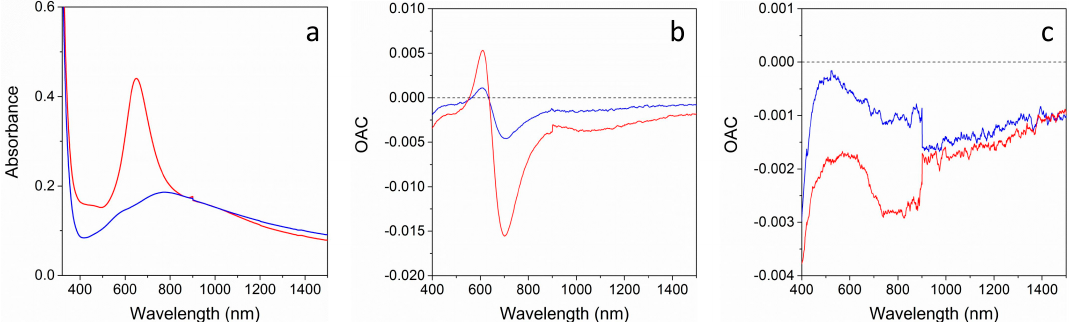
Figure 6. ( a ) Absorbance spectra of NiO-Au-TiO 2 (NAT) (red line) and TiO 2 -Au-NiO (TAN) (blue line). Optical Absorbance Change (OAC) curves for ( b ) NAT sample and ( c ) TAN sample after exposure to 1% CO (blue lines) and 1% H 2 (red lines) at 300 °C OT.